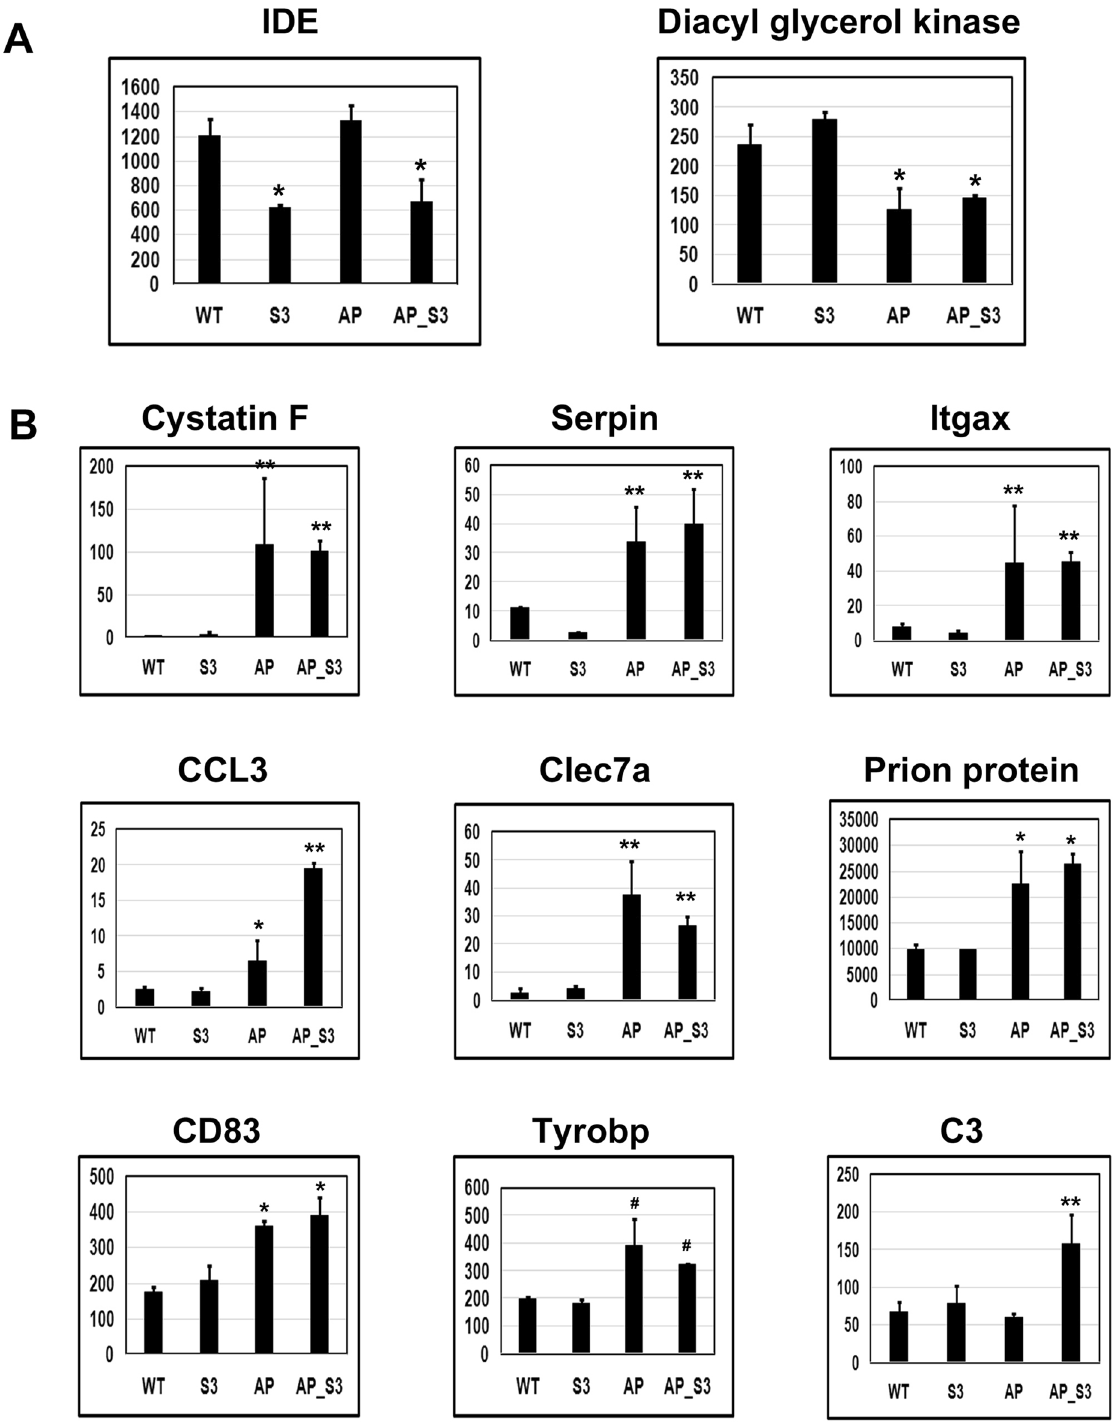
Figure 3. Altered gene expression by Sirt3 gene deletion and amyloid plaque deposition. RNA-seq reads for selected downregulated ( A ) and upregulated ( B ) genes are presented for wild type ( WT ), Sirt3 -/- ( S3 ), APP/ PS1 ( AP ) and APP/PS1/Sirt3 -/- ( AP_S3 ) mouse brain samples. Data are presented as mean ± SE of 3 samples. # P < 0.05; * P < 0.01 and ** P < 0.001 compared to wild type